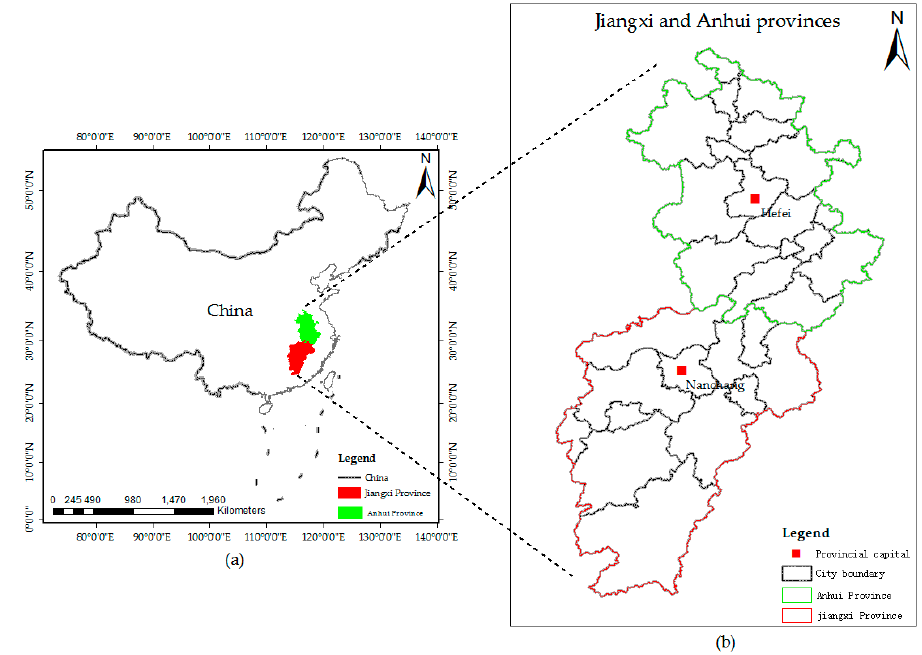
Figure 1. The study site ( a ) locations in China of ( b ) the Jiangxi Province and the Anhui